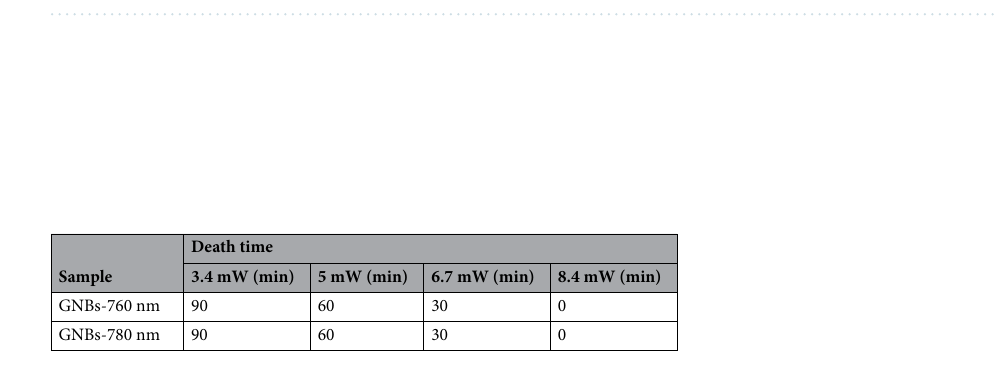
Figure 5. Photothermal treatment of GNBs with an AR of 2.92 under 760 nm continuous laser, the laser focuses on the nano clusters in the cell. The red circle in the figure marks the position of the laser. The selected cell is indicated by white line.